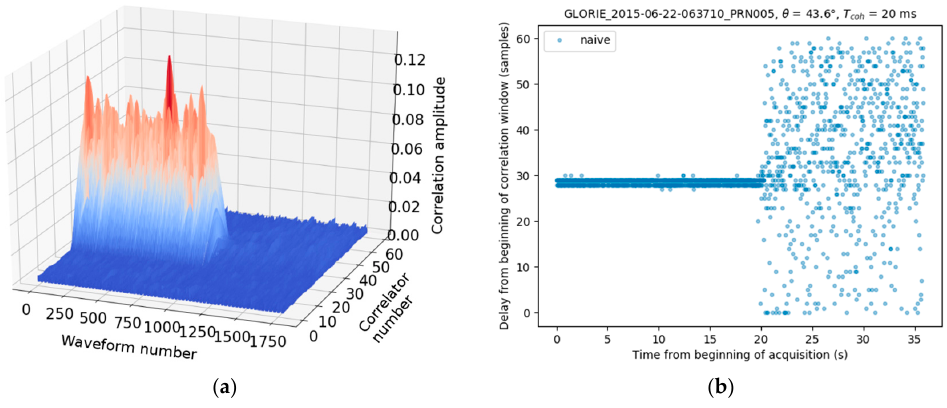
Figure 4. ( a ) Time series of Waveforms for a lake to forest transition; ( b ) Naive estimation (max) of the peak location. Aircraft height is ~650 m AGL.